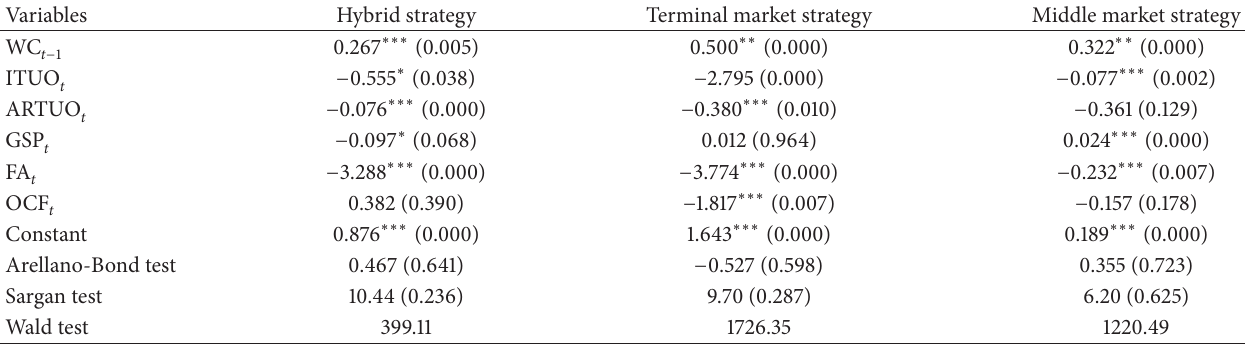
Table 5: Determinants of working capital in three strategic